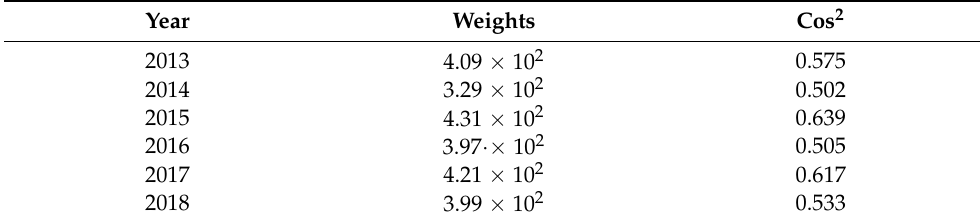
Table 3. Weights and quality of representation of each matrix on the